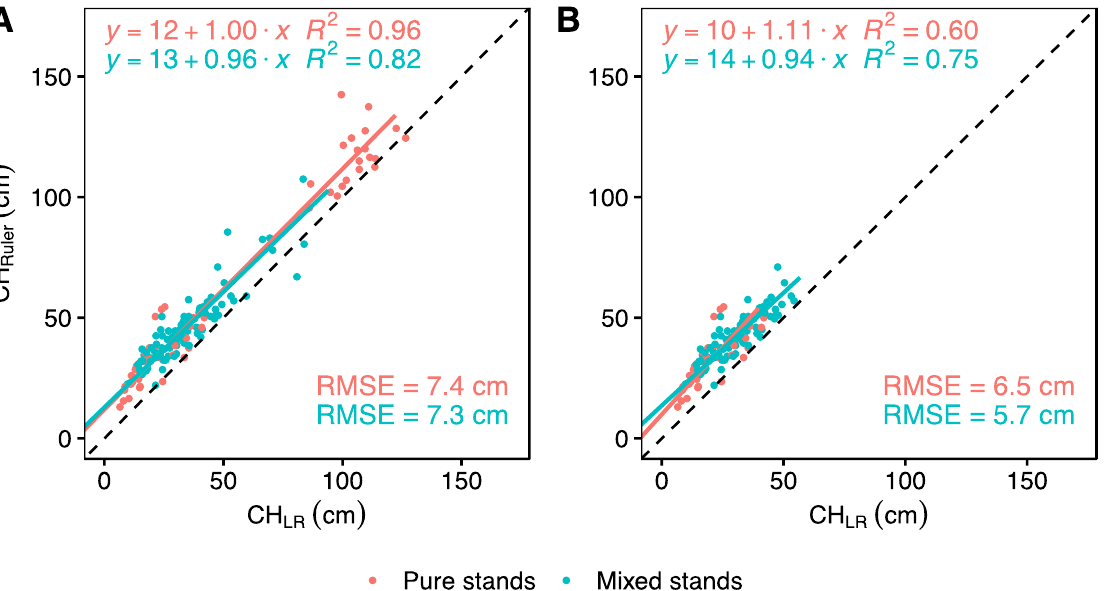
Figure 4. Linear relationship between canopy height from low-resolution UAV mission (CH LR ) and manual height measurement with a ruler (CH Ruler ) of cover-crop treatments for ( A ) the whole dataset and ( B ) the dataset excluding plots containing mustard plants clustered in pure stands (n = 56 for ( A ) and 36 for ( B )) and mixed stands containing different species (n = 92 for ( A ) and 84 for ( B